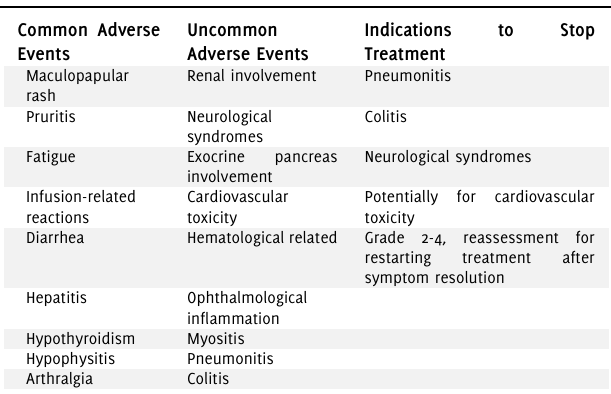
Table 2 . Potential Adverse Events for Immunotherapies for Oncology Treatment.